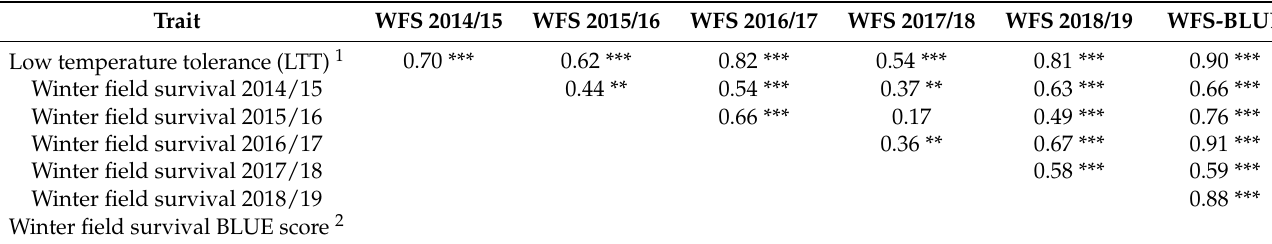
Table 2. Correlations between LTT and WFS.